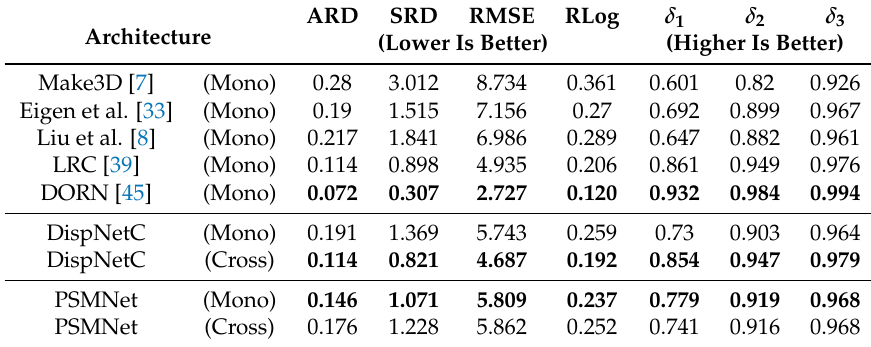
Table 2. Quantitative results for depth prediction from a single image on the test set of KITTI raw